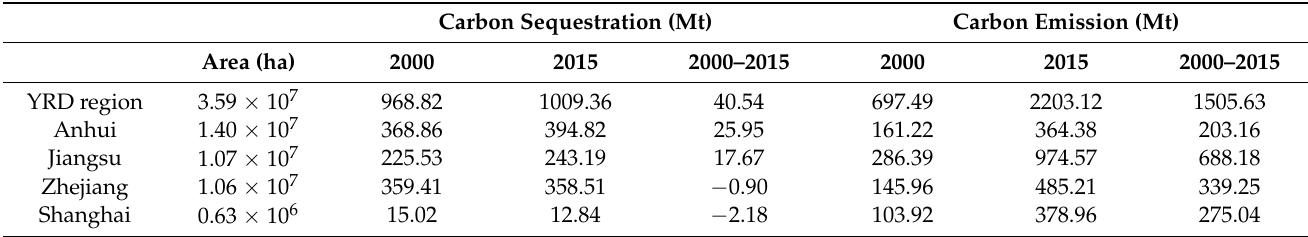
Table 2. Quantitative changes in carbon sequestration and emissions during 2000–2015. Carbon Sequestration